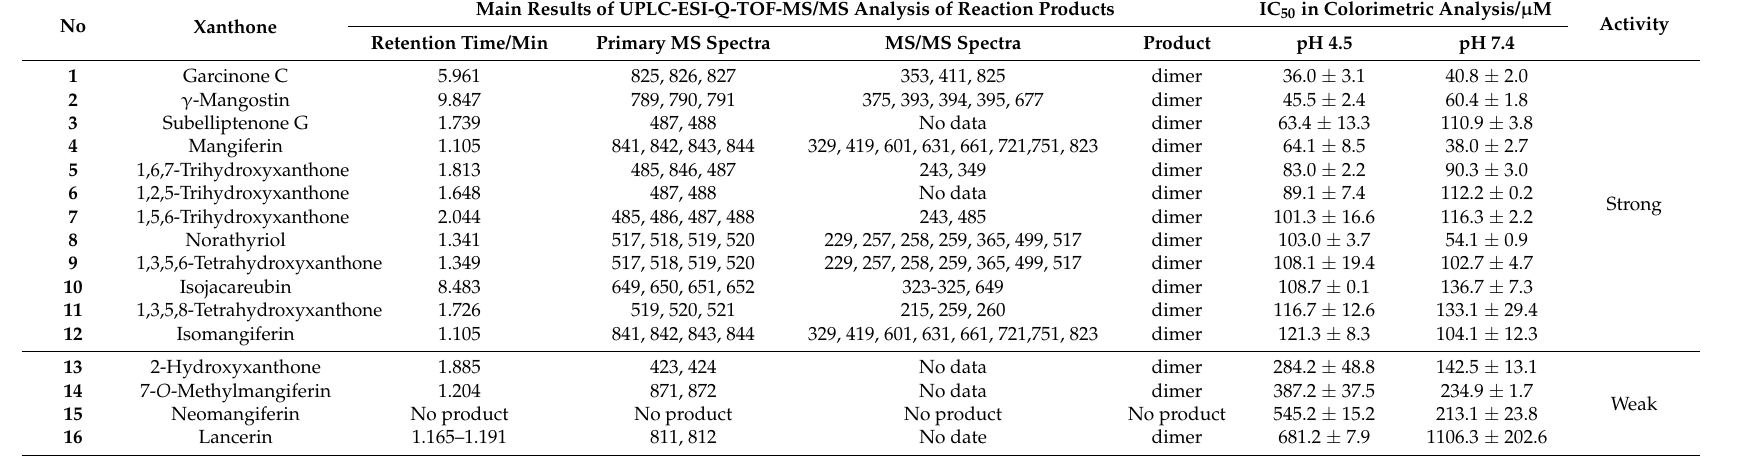
Table 1. The main results of PTIO • -trapping activity of 16 xanthones using UPLC-ESI-Q-TOF-MS/MS analysis and colorimetric analysis. Main Results of UPLC-ESI-Q-TOF-MS/MS Analysis of Reaction